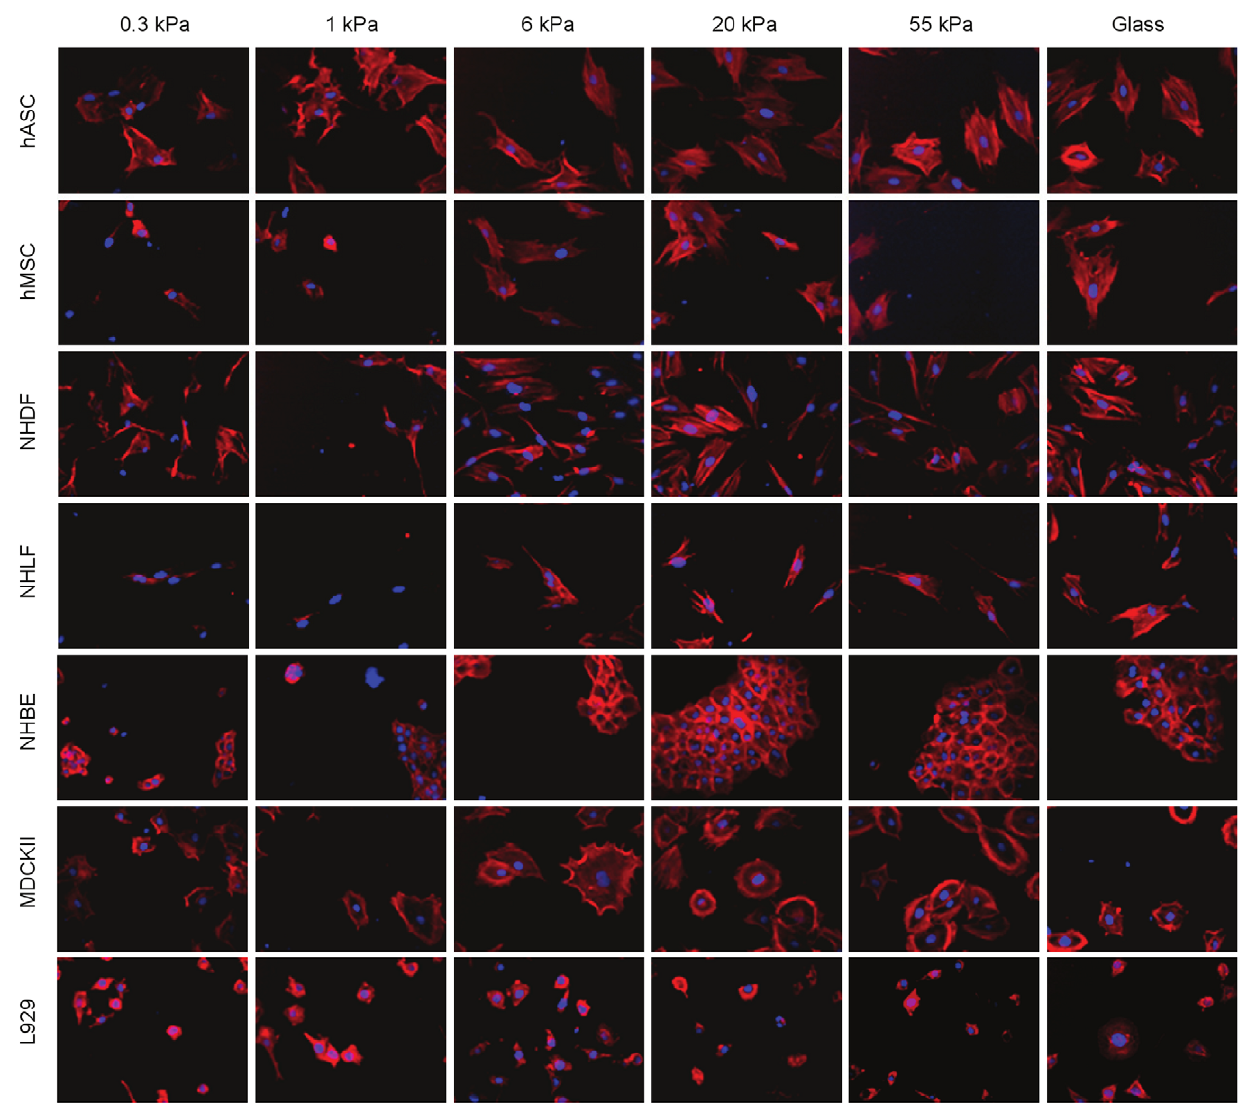
Figure 4. Automated imaging of cell morphology in a 384 well plate. Seven cell types ( Table 1 ) cultured across increasing substrate stiffness, stained for F-actin (red) and nuclei (blue). Images were obtained at 200X magnification.